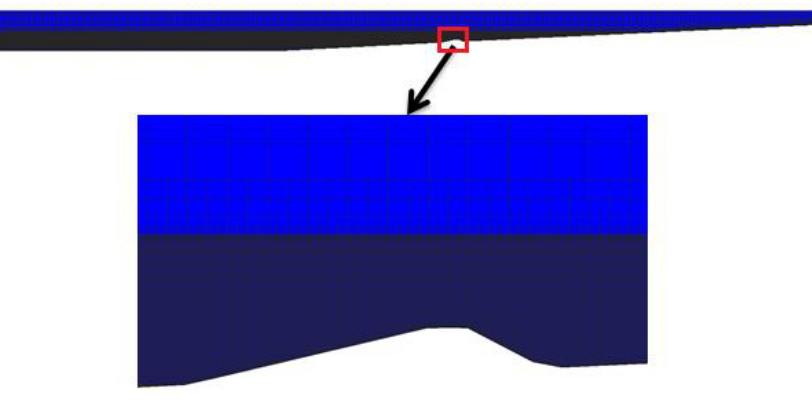
Table 1. Elevation coordinates of the